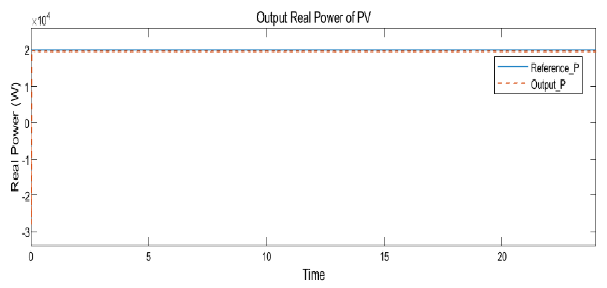
Fig. 3. Output real power of PV with